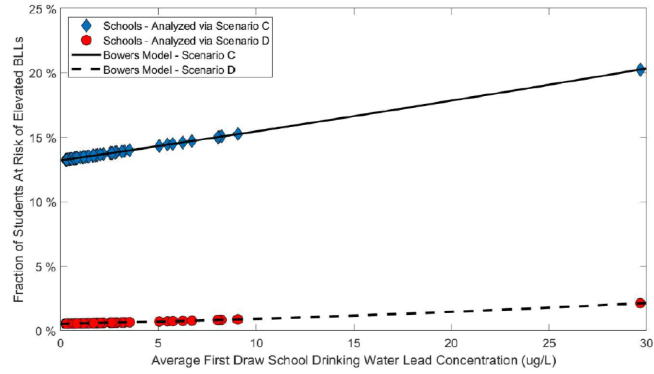
Figure 5. Fraction of at-risk students vs. water lead concentration at secondary schools.